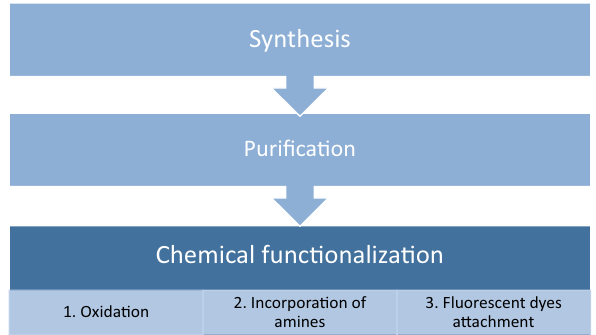
Figure 1: Process fl ow